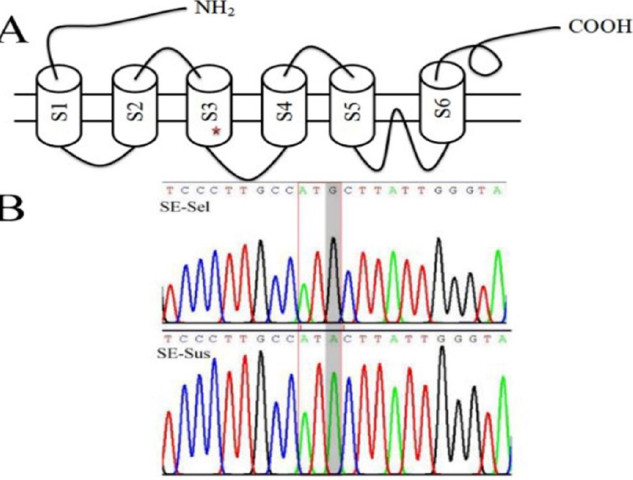
Figure 8. Peak map and structural analysis of cloned partial sequence of RyR in SE-Sel and SE-Sus strains. ( A ) The trans- membrane domain topology; the red star is the location of the mutation; the positions of the transmembrane spanning domains S1 toS6 and based on those recently predicted for the diamondback moth RyR; [31,32] ( B ) Peak map; the box marked with black solid line indicates the mutation area, similarly